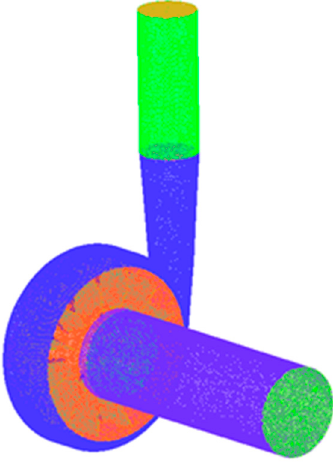
Figure 3. Vortex pump meshing.